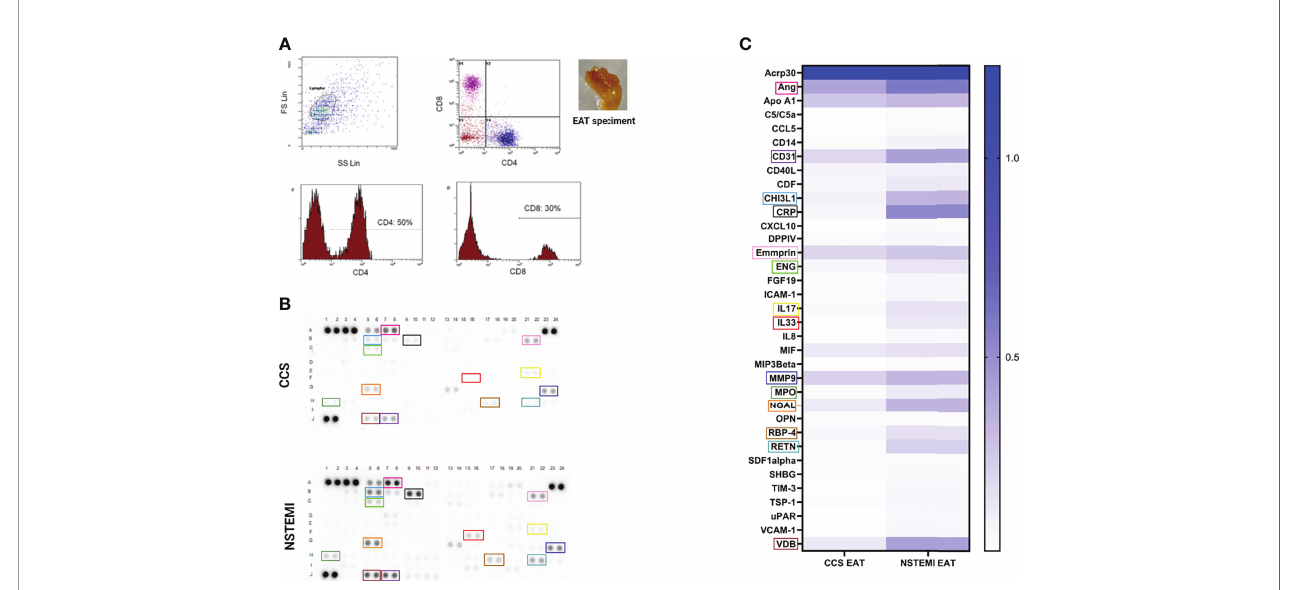
FIGURE 2 | Flow cytometry characterization of EAT-resident T cells and proteome pro fi ling of EAT specimens. (A) A phenotypic characterization of EAT-resident T cells was performed by fl ow cytometry in NSTEMI ( n = 10) and CCS ( n = 10) patients. A representative fl ow cytometry analysis is displayed and the EAT specimen of one patient is shown. About 50% of EAT-in fi ltrating T cells were CD4 + , while 30% were CD8 + without differences among groups. (B) An in fl ammatory proteome pro fi ling was performed in NSTEMI ( n = 3) and CCS ( n = 3) patients; X-ray fi lms (B) and heatmap analyses (C) are shown [squares of the same color indicate the same molecule in (B , C) ]. NSTEMI and CCS patients signi fi cantly differed for multiple immune-related